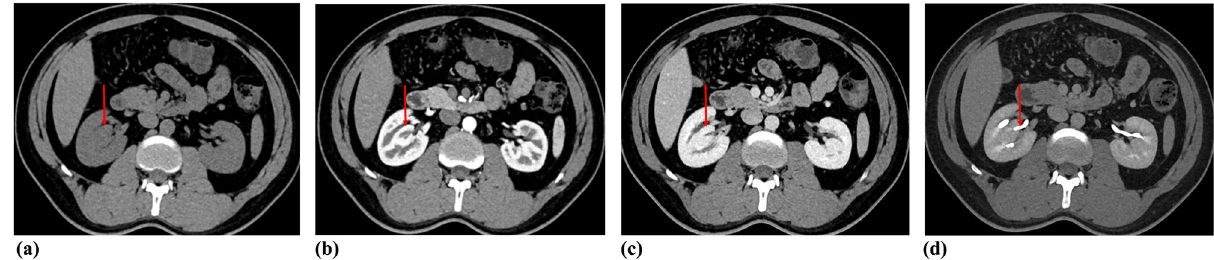
Figure 2: Axial precontrast ( a ) and contrast - enhanced ( b and c ) CT showed oval solid mass ( red arrows ) in right renal sinus with identical density and enhancement pattern to adjacent normal renal cortex. In pyelographic phase image ( d ) exhibited the small renal pelvis ( red arrow ) from the pseudo - mass merging into the right renal pelvis.